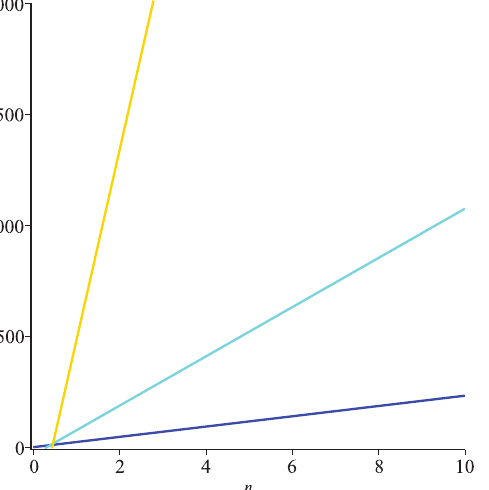
Figure 8: Graphical comparison of H (G), IS (G), and AZI (G) are labeled in blue, cyan, and gold graphs, respectively, for MON